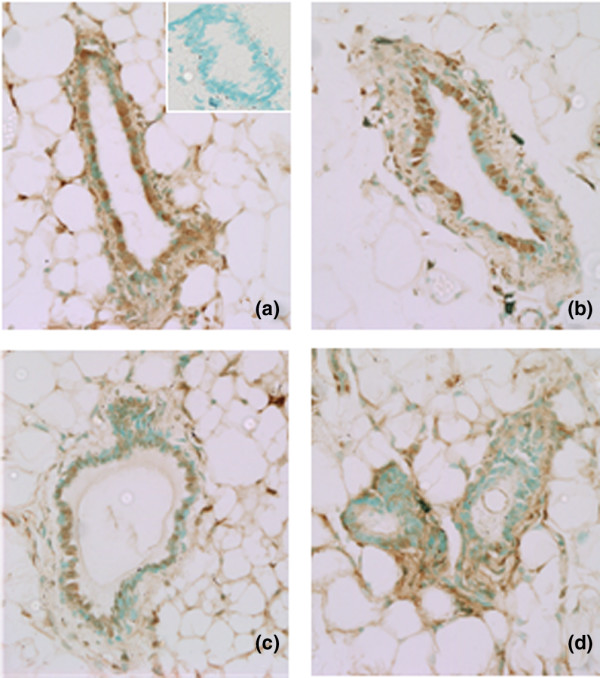
Effects of asPR or RU 486 on PR expression in mammary glands. Immunohistochemical staining for PR in sections of paraffin-embedded mammary glands of mice treated with (a) saline, (b) scPR, (c) asPR, or (d) RU 486 for 5 days. Inset: control, in which no primary antibody was added. Primary antibody: PR polyclonal (C-20; Santa Cruz Biotechnology). The procedure was performed as described in Materials and method. asPR, antisense oligodeoxynucleotides to progesterone receptors; PR, progesterone receptor; scPR, scrambled oligodeoxynucleotides to progesterone receptors.